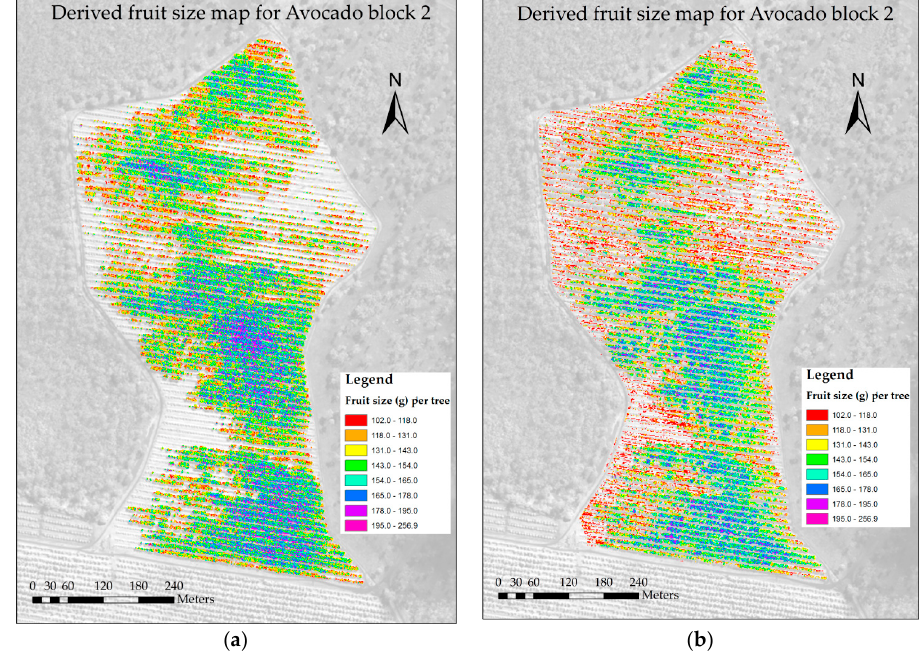
Figure 9. Classified fruit size (g) per tree maps derived from the best fit model of the relationship between VIs and average fruit size (g) per tree for Block 2 in ( a ) 2016 and ( b ) 2017.